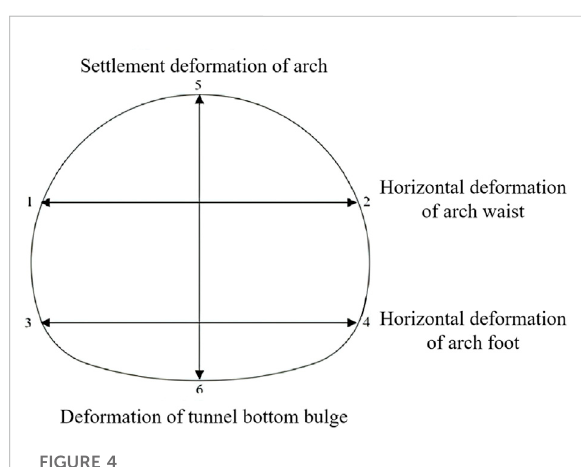
FIGURE 4 Layout of measuring points in the monitoring